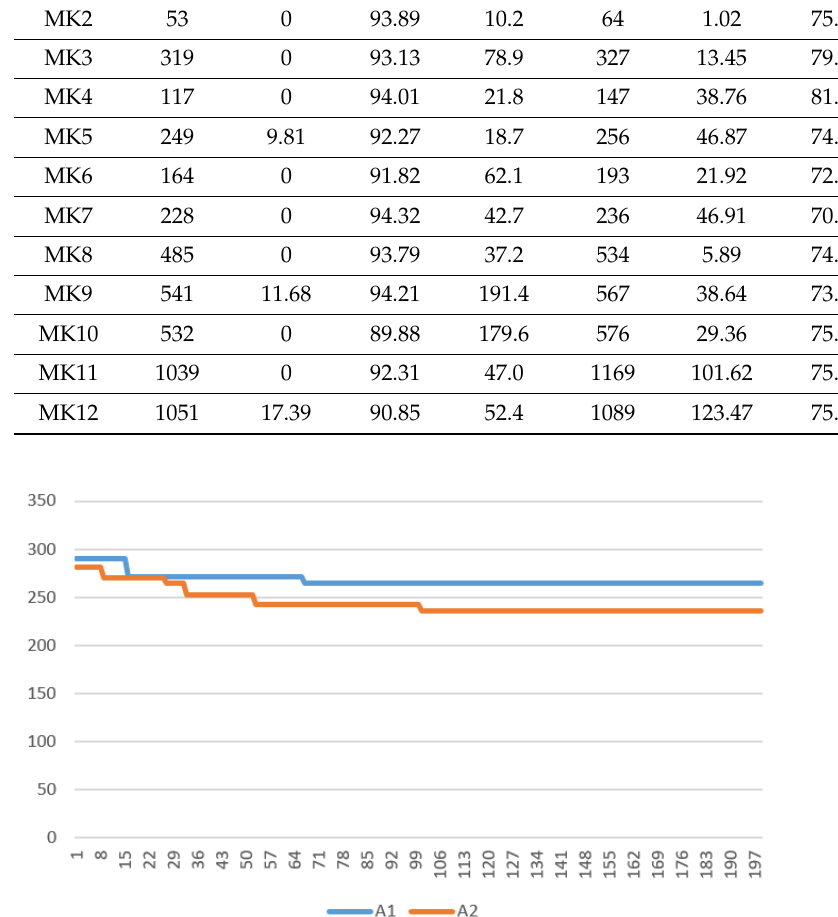
Table 3. Running results of the said 12 cases with the two algorithms.